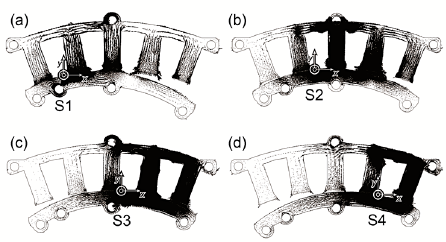
Figure 7. The normalized distribution of the magnetic flux density vectors: ( a ) S1, ( b ) S2, ( c ) S3, and ( d ) S4.